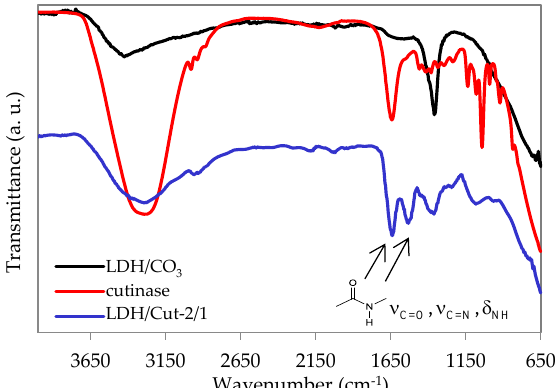
Figure 2. ATR FT-IR curves of LDH/Cut-2/1, cutinase, and LDH/CO 3 as a reference sample.